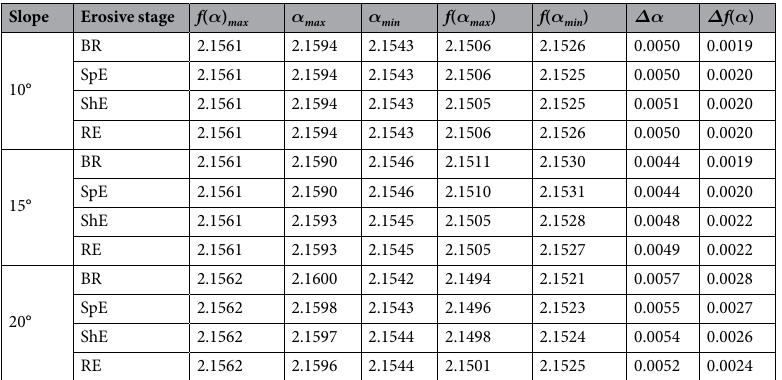
Table 2. MFA of micro-relief characteristics at different erosive